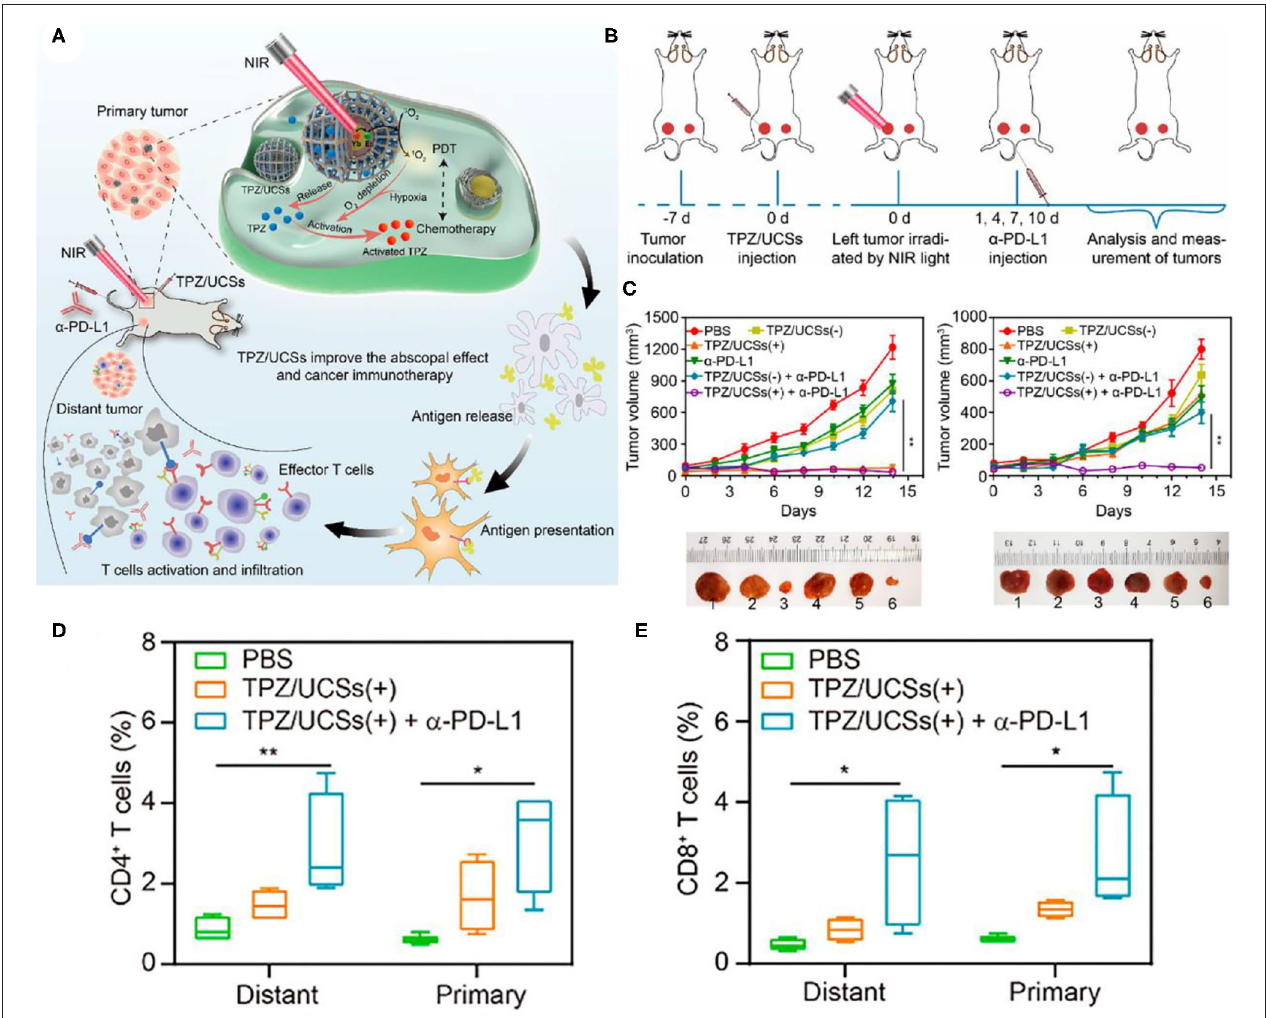
FIGURE 9 | (A) Schematic illustration of the structure of TPZ/UCSs and their application to tumor treatment through a combination of NIR light-triggered PDT and hypoxia-activated chemotherapy with immunotherapy. (B) Schematic illustration of NIR light-triggered combinational therapy. (C) Growth curves of primary tumors (left) and distant tumors (right) in CT26 tumor-bearing mice after different treatments. Photographs of primary tumors and distant tumors collected from mice 14 days after treatments: (1) PBS, (2) TPZ/UCSs(–), (3) TPZ/ UCSs( + ), (4) α -PD-L1, (5) TPZ/UCSs(–) + α -PD-L1, and (6) TPZ/UCSs( + ) + α -PD-L1. Percentage of tumor-infiltrating (D) CD4 + T cells, (E) CD8 + T cells in total tumor cells. Data are means ± SD; N = 4. * P < 0.05, ** P < 0.01. Copyright 2020, American Chemical Society (Shao et al.,